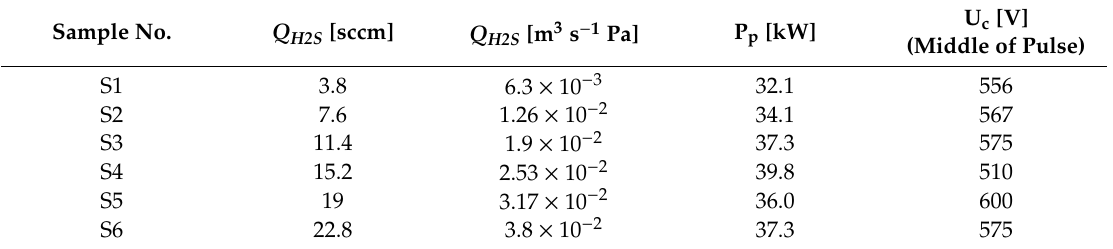
Table 1. Deposition conditions of deposited iron sulfide thin films ( Q HS – H2S gass flow rate, P p pulse discharge power, U c cathode voltage).